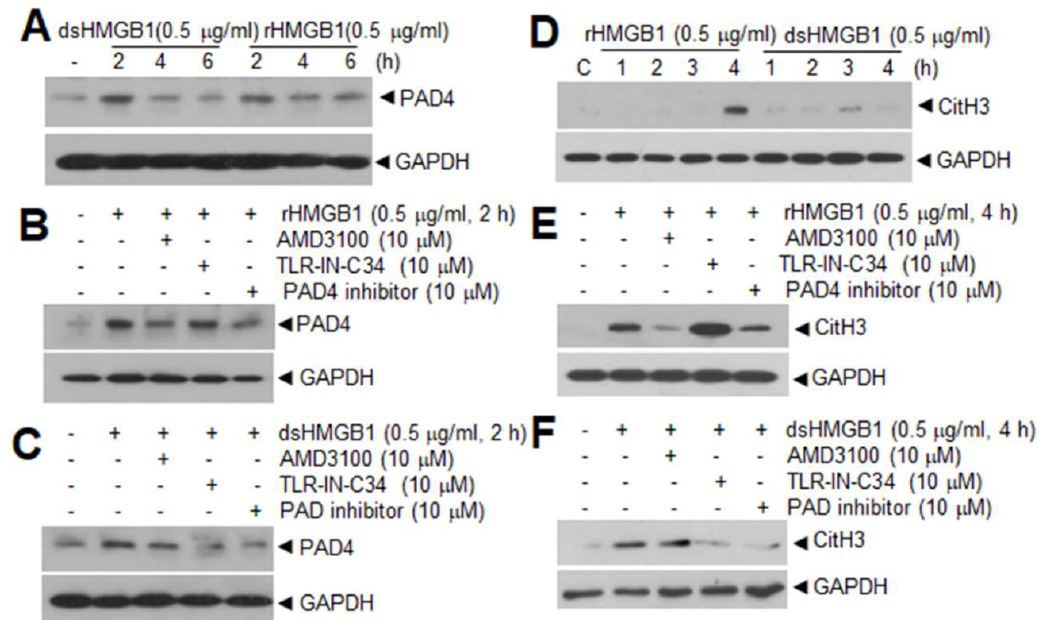
Figure 2. Both all-thiol HMGB1 and disulfide HMGB1 increases PAD4 and CitH3 levels in peripheral neutrophils isolated from the blood. ( A ) PAD4 and ( D ) CitH3 levels were examined by immunoblotting after treating neutrophils isolated from peripheral blood with all-thiol HMGB1 or disulfide HMGB1 (0.5 µg/mL) for indicating durations; ( B , C , E , F ) Blood PMNs were pretreated with AMD3100 (10 µM, CXCR3 antagonist), TLR–IN–C34 (10 µM, TLR4 antagonist) or Cl–amidine (10 µM, a PAD4 inhibitor) for 30 min and then treated with all-thiol HMGB1 (0.5 µg/mL) or disulfide HMGB1